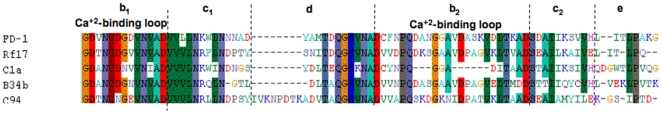
Conservation of ScaA proteins from different R. flavefaciens strains.Protein sequences were adapted from Jindou et al [25]. The N-terminal parts of the sequences are more conserved than the C-terminal part, and the second calcium-binding repeat could not be recognised. Thus, the labels of the dockerin modules (b–e at top) are approximated.